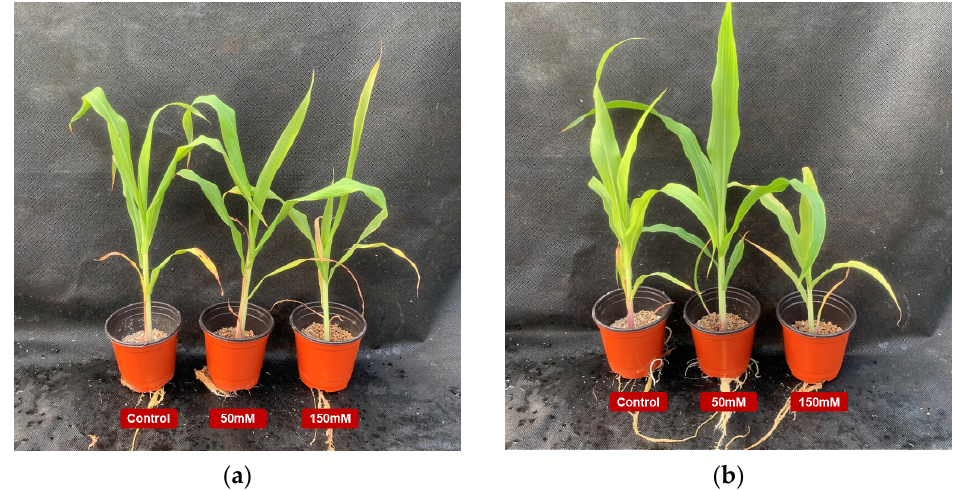
Figure 2. Growth performance nine days after the salt treatment of two sorghum cultivars: ( a ) Nampungchal (salt-tolerant) and ( b ) Sodamchal (salt-sensitive).